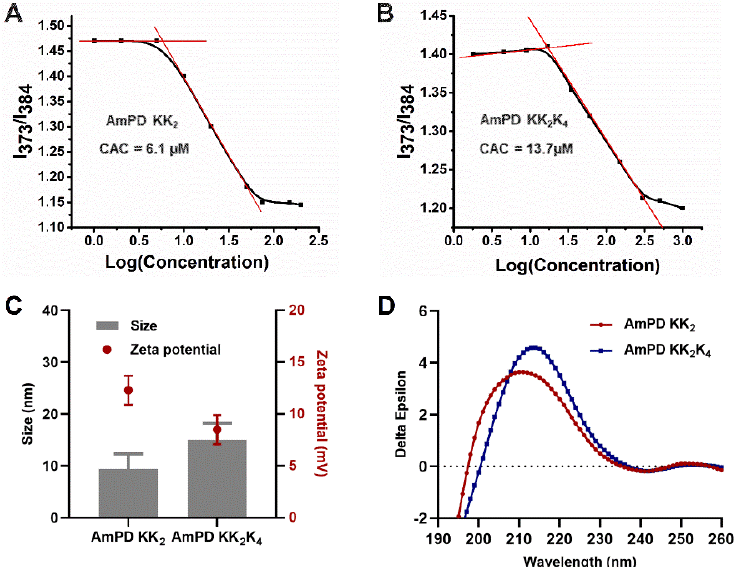
Figure 1. Physicochemical properties of the AmPDs. The CAC of the AmPD KK 2 ( A ) and AmPD KK 2 K 4 ( B ) using the fluorescent dye pyrene. ( C ) Size and Zeta potential of the AmPDs nanoassem- blies (mean ± SD, n = 3). ( D ) The circular dichroism (CD) spectrum of the AmPDs nanoassemblies (0.50 mg/mL in H 2 O).